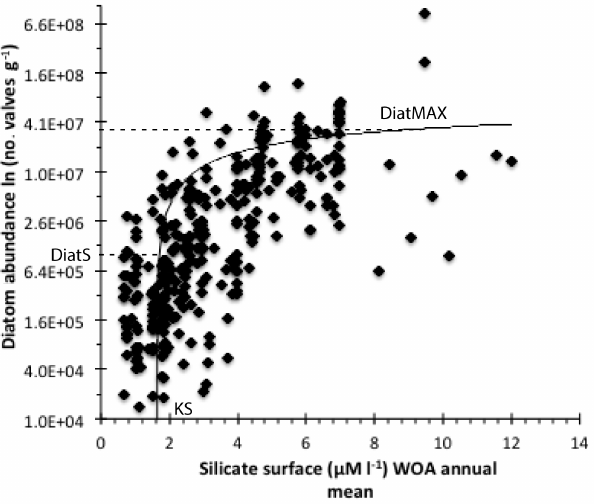
Figure 6. Translation of the Michaelis–Menten model, which de- fines the relationship between population abundance and [Nutrient] with the long-term SDA data set. That relationship is expressed by the mathematical equation V = V max [N] / ( K s + [N]), where ( V ) is the algal population growth rate, ( V max ) is the maximum diatom abundance in the sediments (Diat max ) at threshold [N = Si surfmax ] above which population abundance remains constant, [N − Si surfS ] is the silicate concentration in upwelled surface waters, and ( K s ) is the silicate concentration at Diat max /